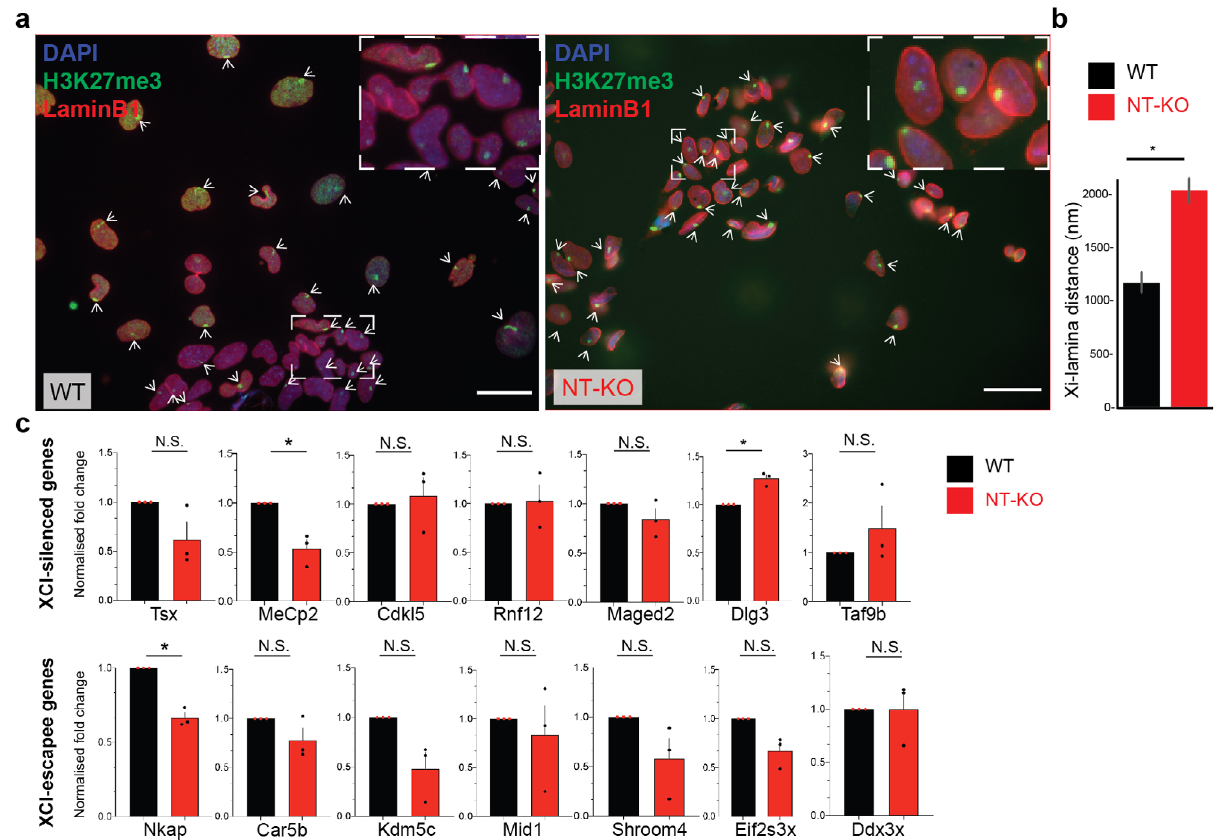
Fig. 3 The reported LBR N-term mutation affects the Xi localization but not gene silencing in random XCI. a Left, Xi-lamina localization is shown by means of H3K27me3/LaminB1 IF. H3K27me3, green; LaminB1, red; DAPI, blue. Dashed boxes indicate Zoom-in images in the top right corner. Arrows indicates the inactive X chromosome. Scale bar indicates ~25 µ m. b Xi-centre-LaminB1 distance quanti fi cation ( n = 681). Samples are color-coded as shown in the legend. Error bars represent standard deviation of the mean (SEM). c qRT-PCR of XCI-silenced and escapee genes 26, 27 . Analyzed genes are shown. Data from three biological samples are shown. * indicates statistical signi fi cance using a two-tailed t -test ( p ≤ 0.05). Error bars represent standard deviation of the mean (SEM). p -values: MeCp2, p = 0.039; Dlg3, p = 0.020, Nkap, p = 0.011. Gapdh has been used as an internal normalization